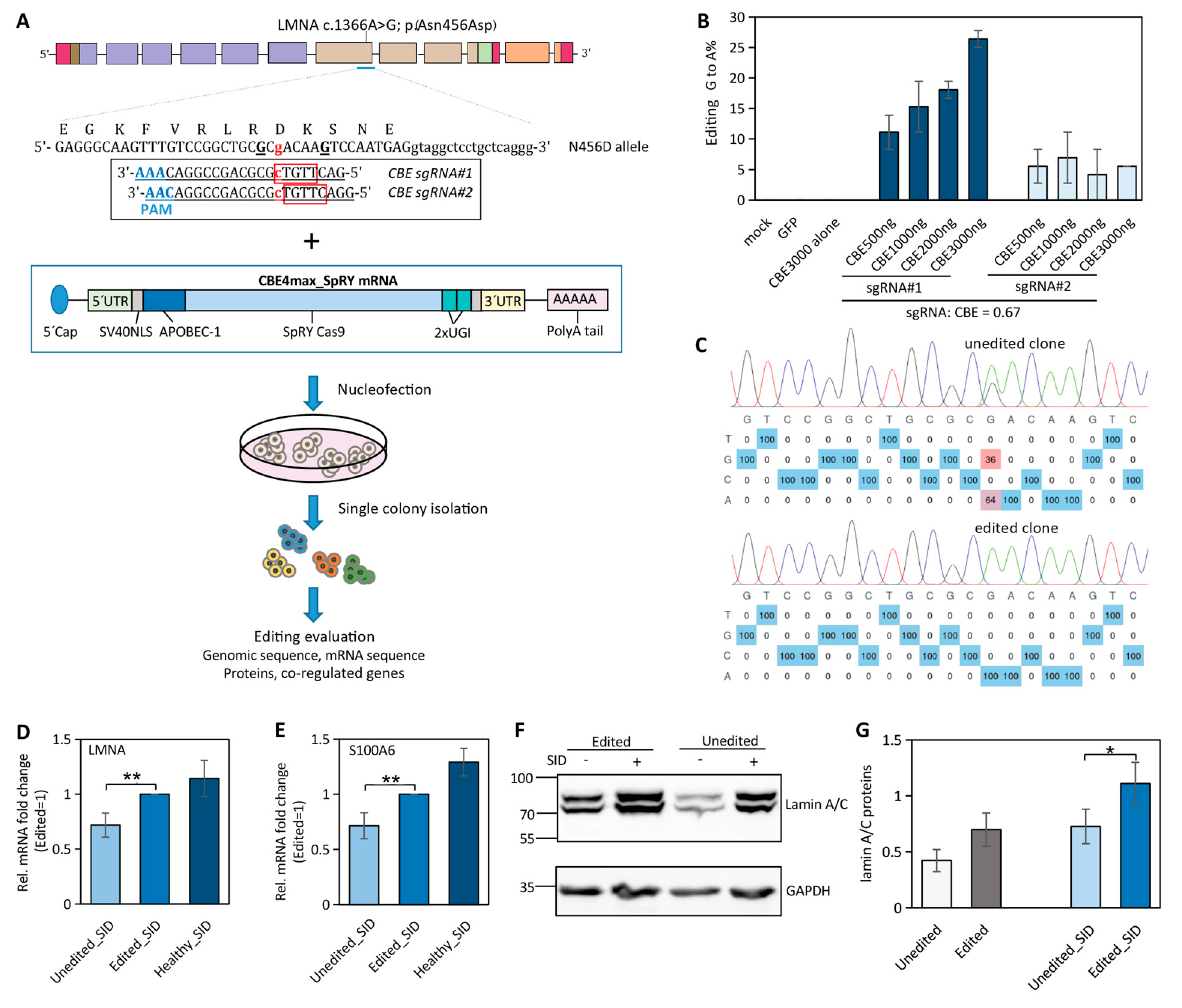
Figure 4. Cytosine base editing in LMNA patient-derived iPSCs. ( A ) Scheme of using mRNA of CEB4max_SpRY and sgRNA to correct mutation in LMNA mutated allele and the following evaluation procedures. Editing window in red frame; PAM sequences were highlighted in light blue. ( B ) Editing efficiency of sgRNAs in iPSC LMNA N456D_C2 cells. ( C ) Genome sequence of unedited and edited clones. ( D , E ) The mRNA levels of LMNA and its co-regulated gene in edited vs unedited iPSC N456D_C2 after SID (N = 3; p < 0.005, **). Healthy_SID includes both healthy1 and healthy2. ( F , G ) Lamin A/C protein levels of edited vs unedited iPSC N456D_C2 prior to and after SID (N = 3; p < 0.05, *). Healthy_SID includes both healthy1 and healthy2. Healthy1 and healthy2: hiPSC LMNA_WT/LMNA_WT ; W498C: patient hiPSCs LMNAc.1494G>T/LMNA_WT ; N456D_C1